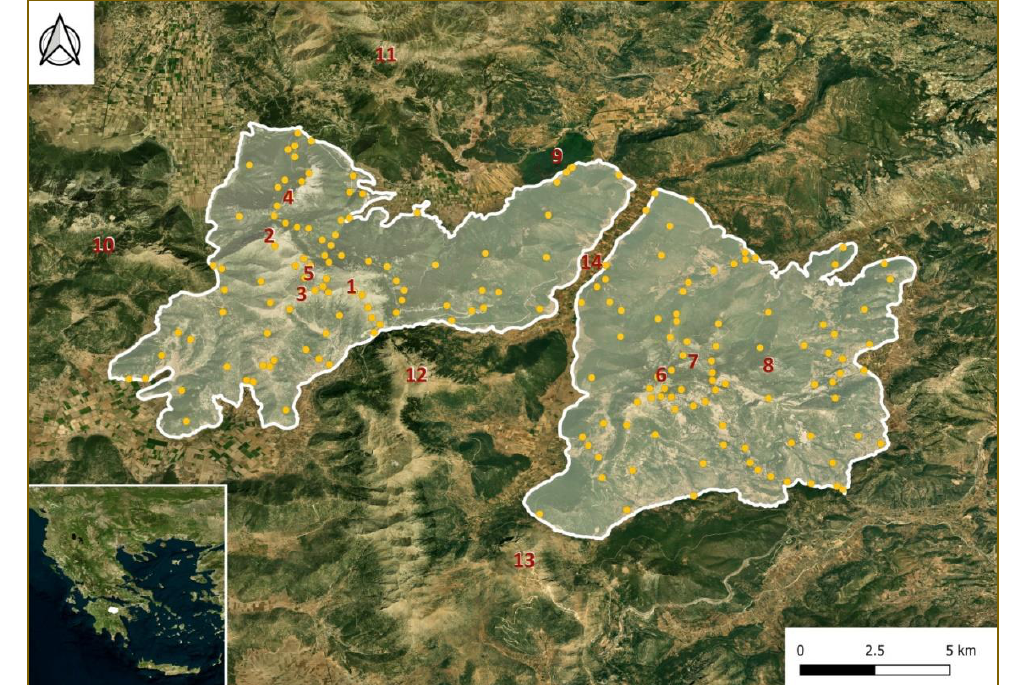
Figure 9. Map of the study area shown in white. Mt. Oligirtos (left) covers a total area of 104.71 km 2 ; Mt. Farmakas (right) an area of 114.76 km 2 . Localities, where plant collections were undertaken, are shown by orange dots (neighboring localities in the same habitat have been merged for visualization reasons). The location of the study area in relation to continental Greece is also indicated (insert). 1: Skipiza summit (1935 m), 2: Gribini summit (1831 m), 3: Chionotripa summit (1800 m), 4: